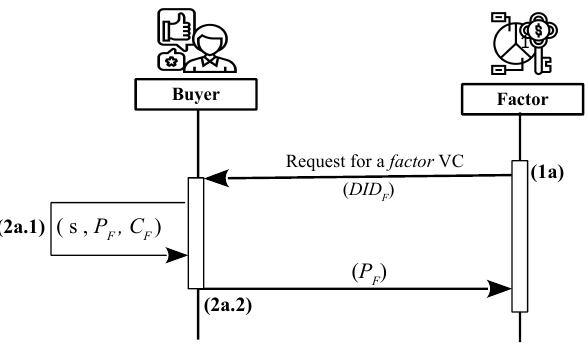
Figure 2. Registration of a factor ’s